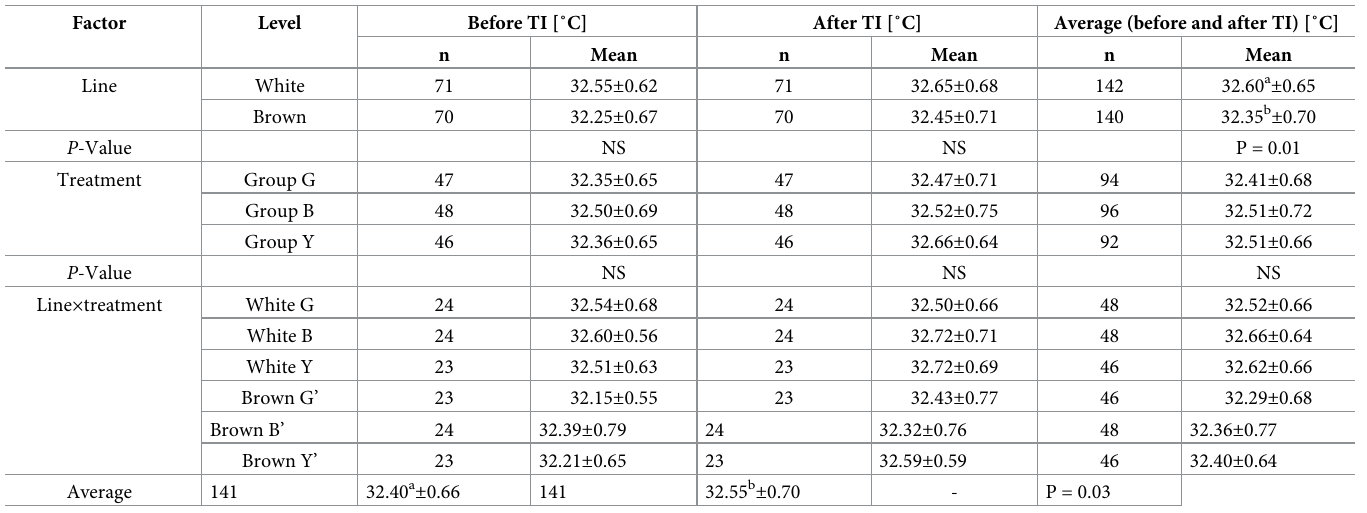
Table 3. Means and standard deviations for individual factors for the temperature of the right eye (RE). Factor